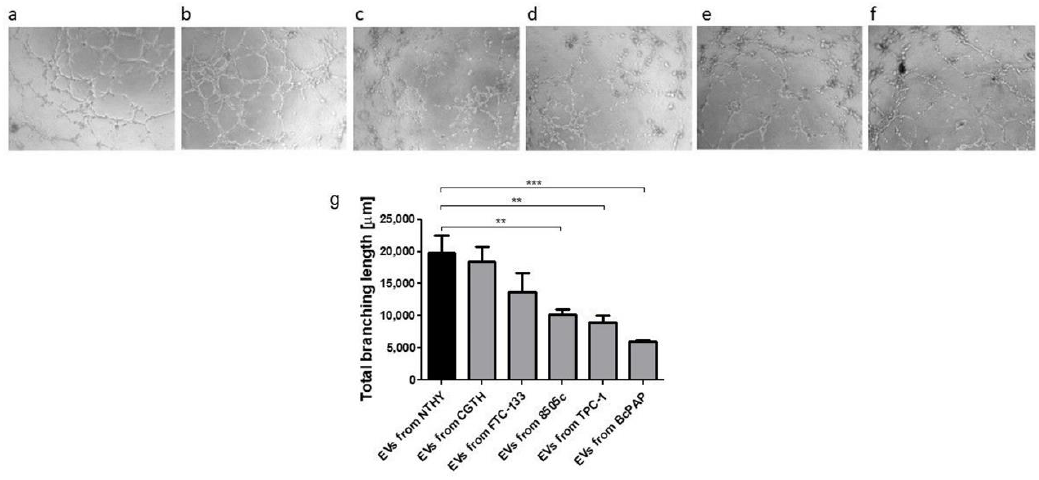
Figure 9. The effect of thyroid-derived EVs on angiogenesis. Upper panel: microscopic analysis of tube formation assay after 5 h: HUVEC cells incubated with: ( a ) — EVs from NTHY; ( b ) — EVs from CGTH; ( c ) — EVs from FTC-133; ( d ) — EVs from 8505c; ( e ) — EVs from TPC-1; ( f ) — EVs from BcPAP; Lower panel: ( g ) — total branching length (Data are reported as mean ± SEM, **: p < 0.01, ***: p < 0.001).